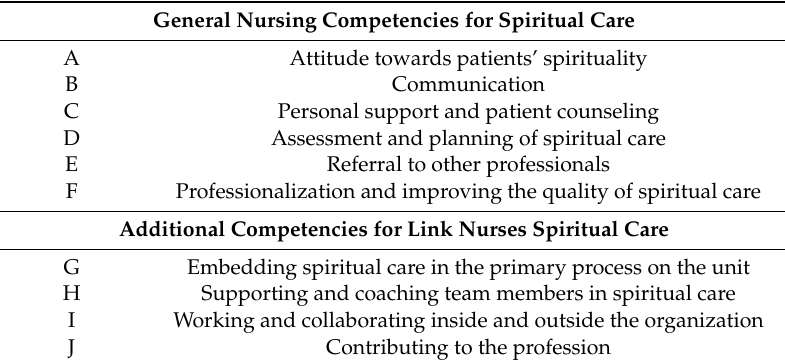
Table 1. Spiritual care competencies for nurses and link